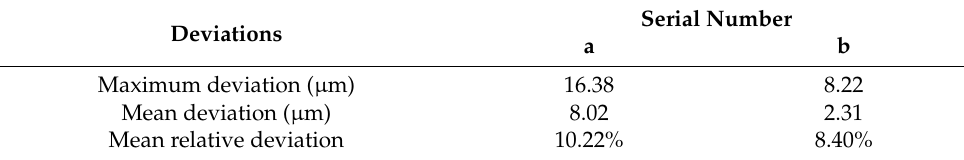
Figure 24. Comparison of the experimental results for Exp. 3 and the simulation results: ( a ) cross-section of electrodes at 0°, ( b ) cross-section of electrodes at 90°, and ( c ) cross-section of microgrooves. Table 7. Deviations of the microgroove profile between simulation and Exp. 3.